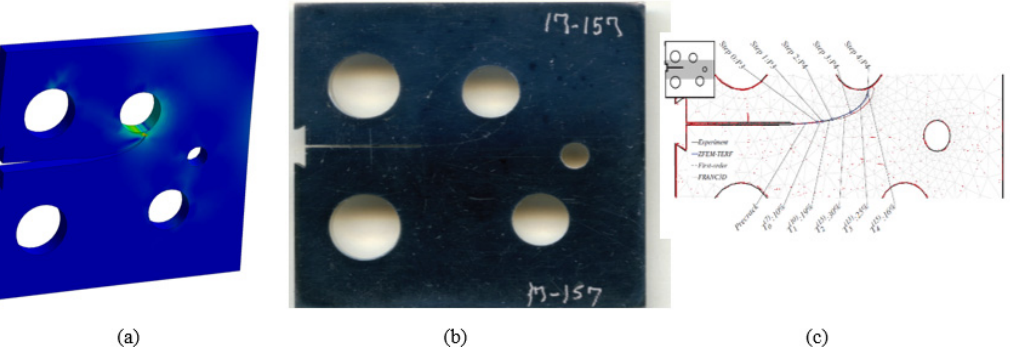
Figure 4. Specimen 1, crack propagation path ( a ) ANSYS results, ( b ) experimental results [46], and ( c ) numerical results [47].